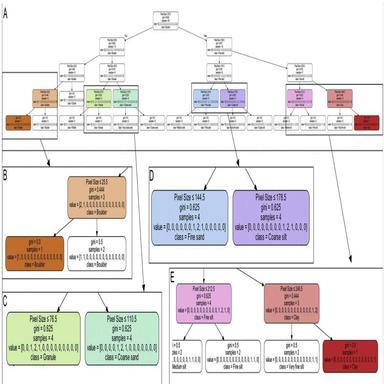
Random Forest classification was used to eliminate the problem of overfitting that is present with decision trees. It also used the pixel size, which was correlated to sediment class. The "anthro" label refers to anthropogenic features such as shipwrecks.